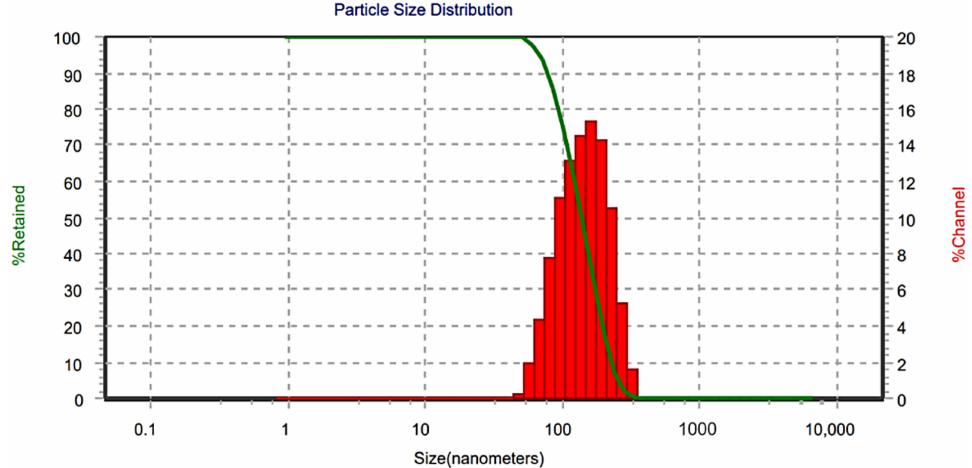
Figure 7. Size distribution after redispersion of tadalafil self-nanoemulsifying chewable tablets (TDL-SNECT)